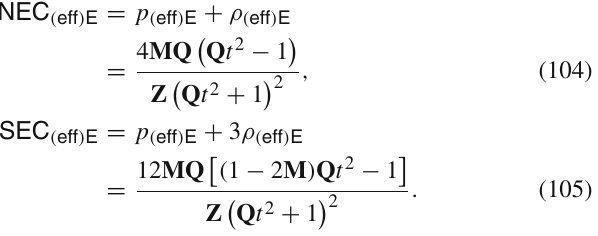
Fig. 8 The behavior of the NEC and SEC for the model E , left panel for M = 0 . 7 and right panel for M = 0 . 3. We see that These conditions are violated near the bounce and it is possible to be respected far away from the bounce (see Eqs. (104) and (105) and the subsequent